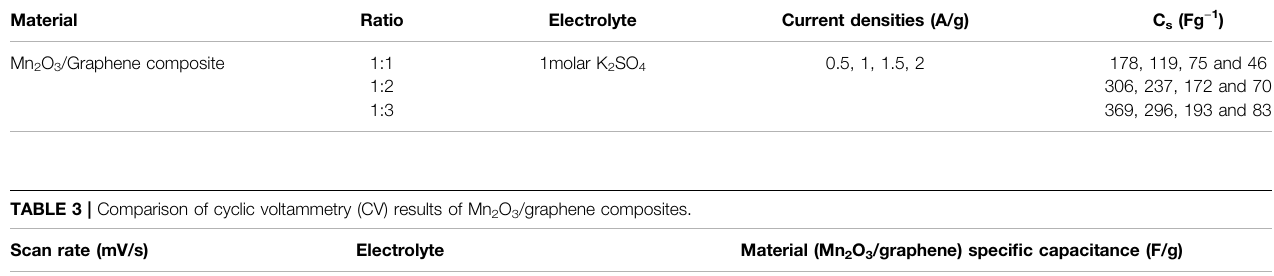
TABLE 2 | Comparison of speci fi c capacitance at different current densities. Material Ratio Electrolyte Current densities (A/g) Mn 2 O 3 /Graphene composite